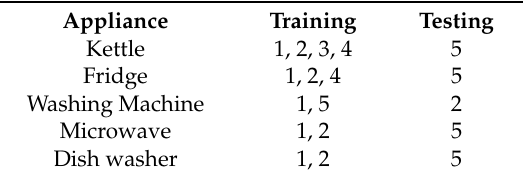
Table 2. Houses used for training and